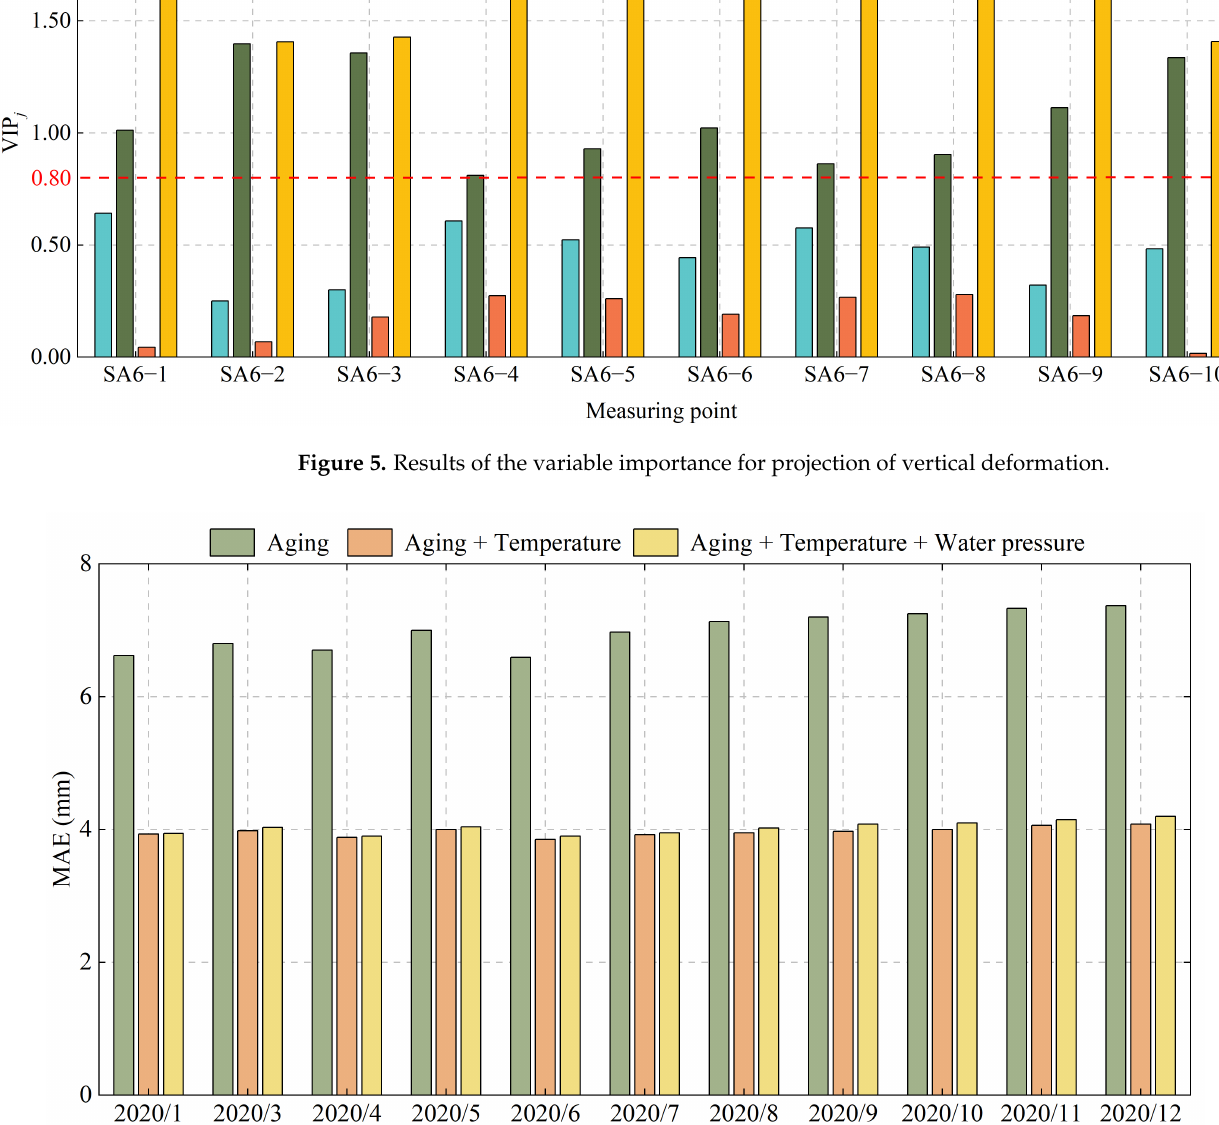
Figure 6. Comparison of MAE with selection of different covariates of the one–dimensional model.